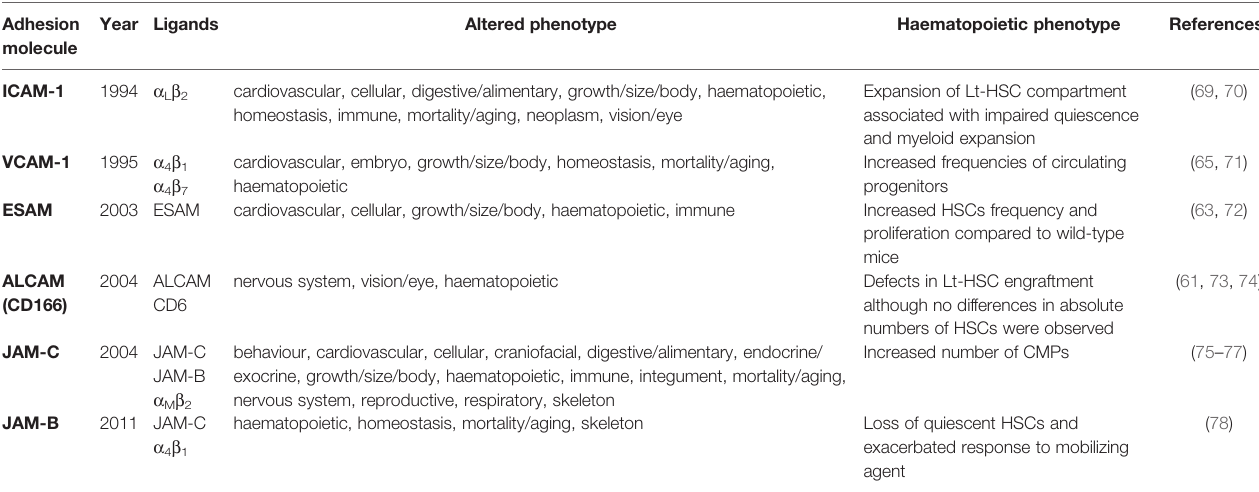
TABLE 1 | Knock-out mice of Ig Sf molecules presenting haematopoietic